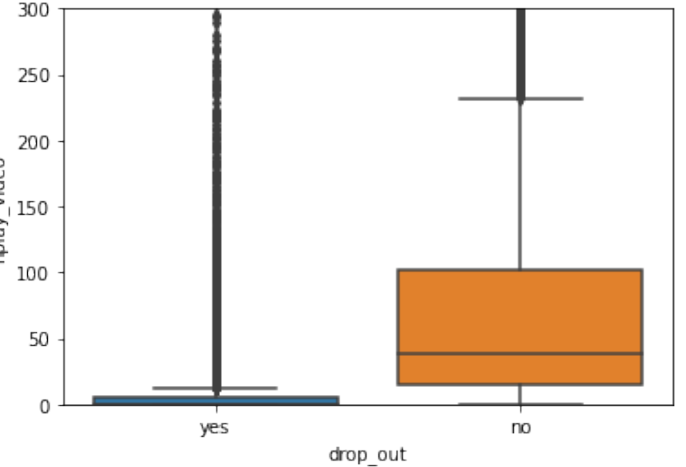
Figure 9. Average number of videos played by dropout students and non-dropout students.